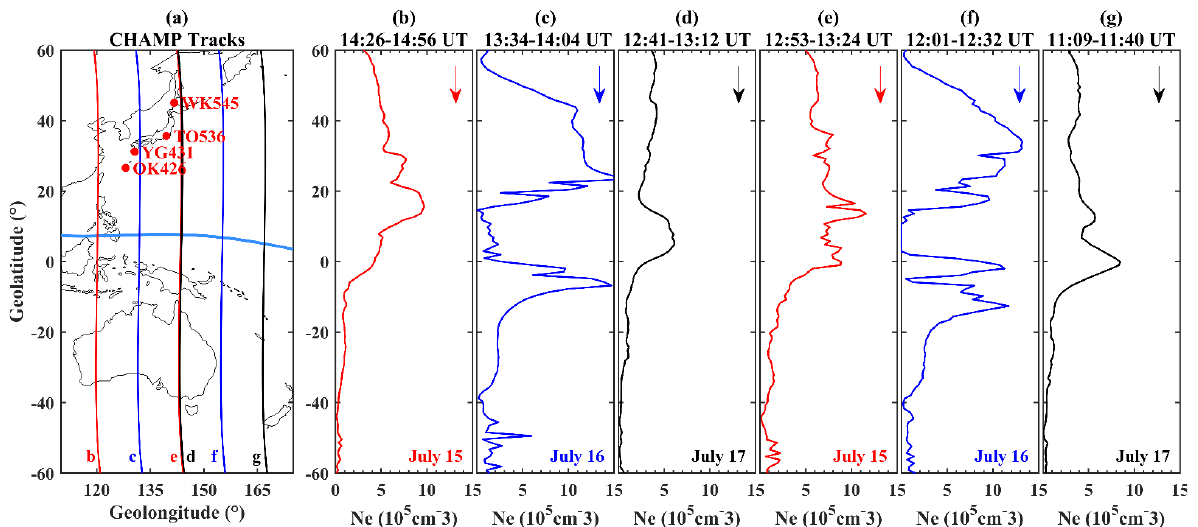
Figure 10. ( a ) CHAMP descending tracks marked with the corresponding right subgraph labels over the Eastern Asian sector during 11 – 15 UT on 15 (red), 16 (blue), and 17 (black) July 2003. The red dots represent the geographic location of the four ionosondes (WK545, TO536, YG431, and OK426 used in this study). The blue lines indicate the geomagnetic equator. The corresponding in situ elec- tron density (Ne) variations as a function of geographic latitude are shown in right panels ( b – g ), respectively. The arrows indicate the descending orbits.